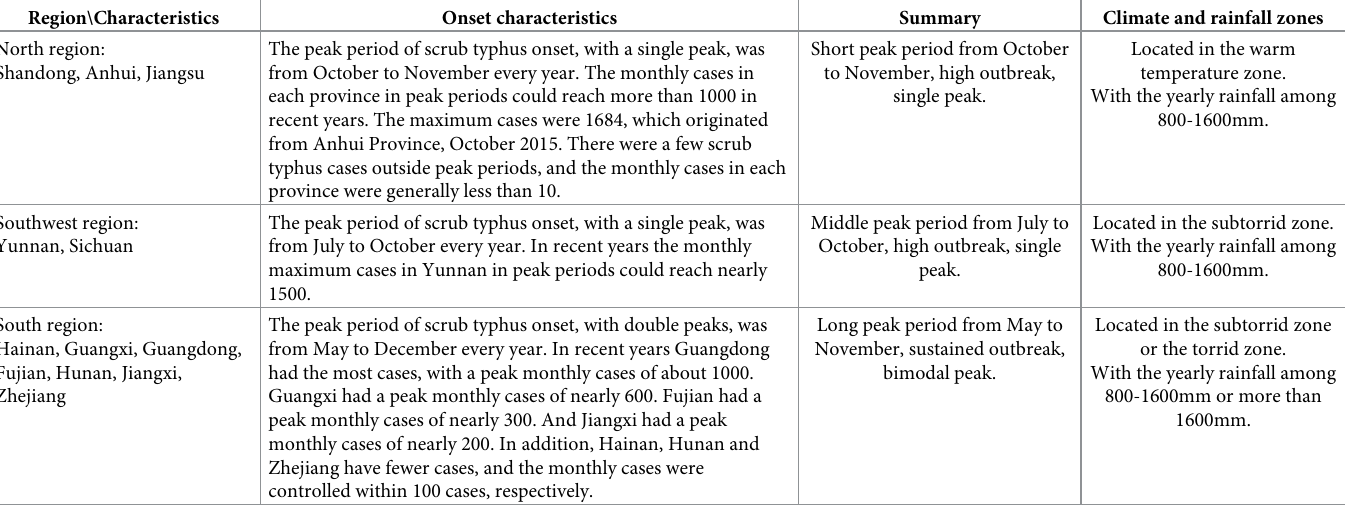
Table 1. The onset characteristics of scrub typhus in the key sub regions.